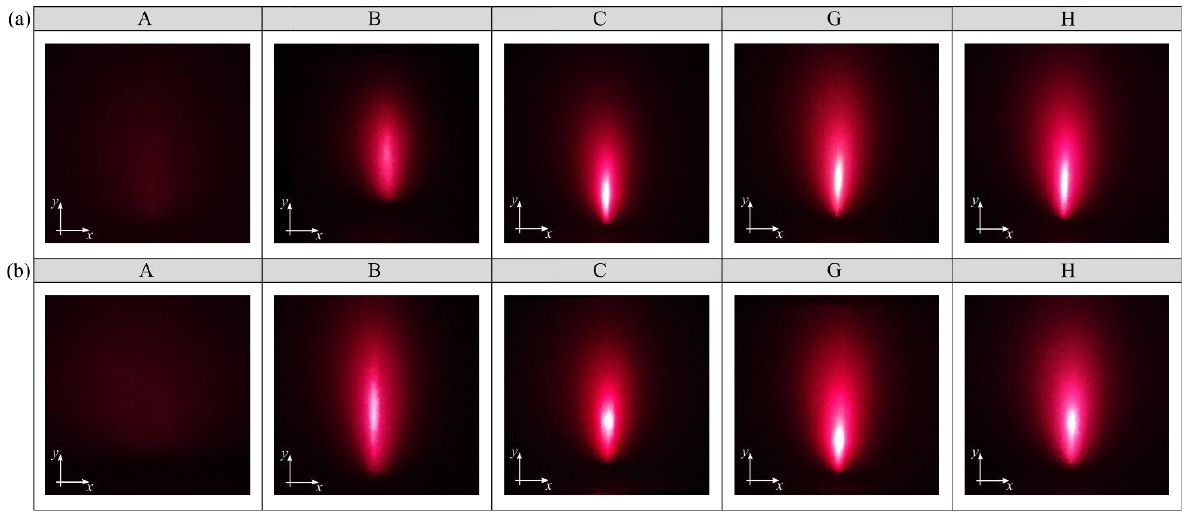
Figure 5. Images of the angular distribution of scattered light intensity obtained from the reflection of a laser light beam with a wavelength λ = 635 nm directed: ( a ) perpendicular; ( b ) parallel at an incidence angle of 80° to machining marks (striation). A-H are identification marks of glass workpieces.